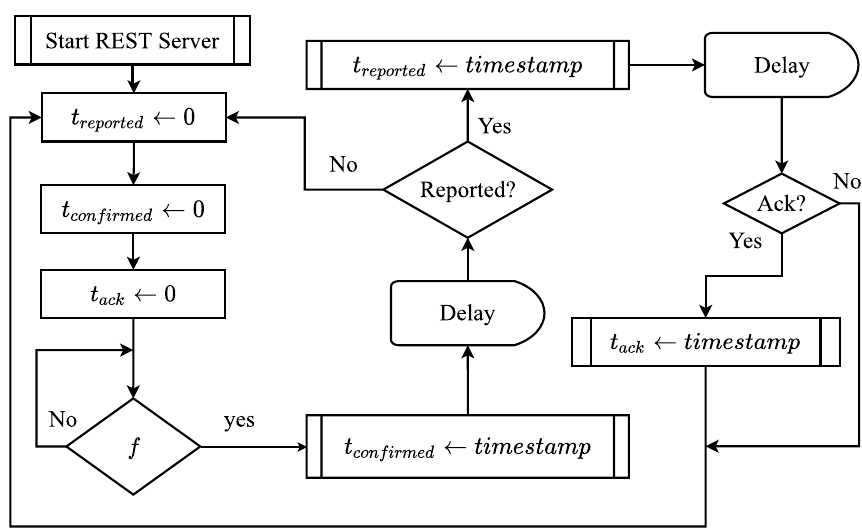
Fig. 11 Instrumenting and exposing relevant metrics at server